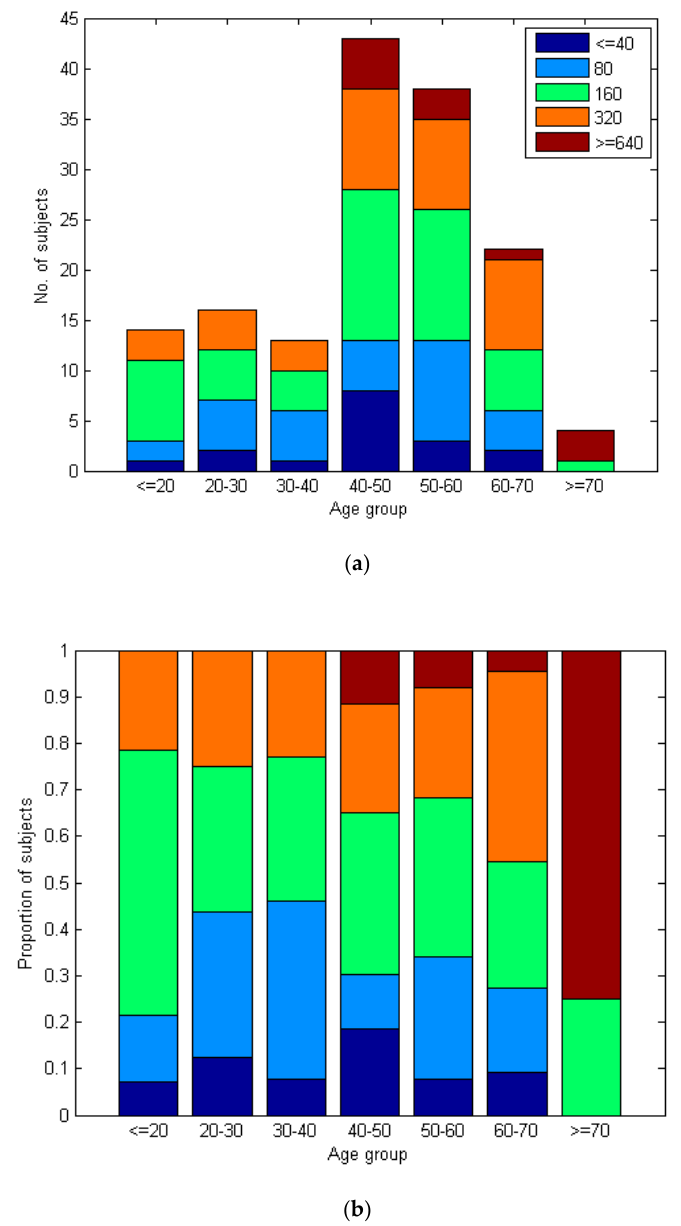
Figure 2. ( a ) The number of VNT results across several age groups. ( b ) The proportion of VNT results across several age groups. Legend: The proportion of VNT ≥ 320 subjects visibly grows with age, while the proportion of VNT ≤ 80 decreases.